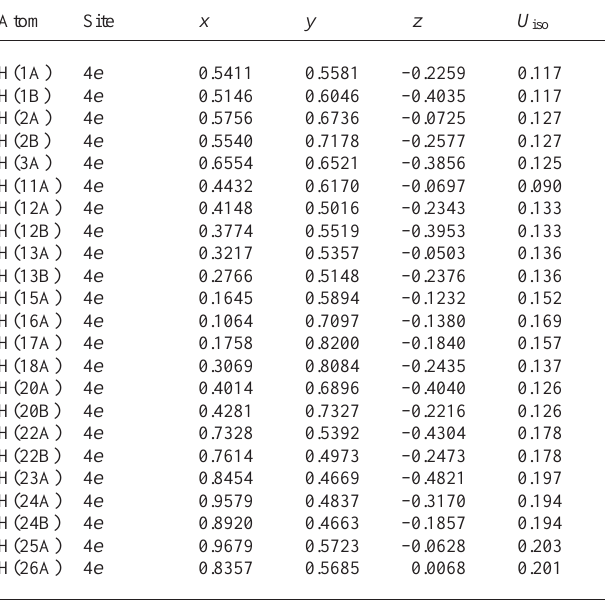
Table 2. Atomic coordinates and displacement parameters (in Å 2 )